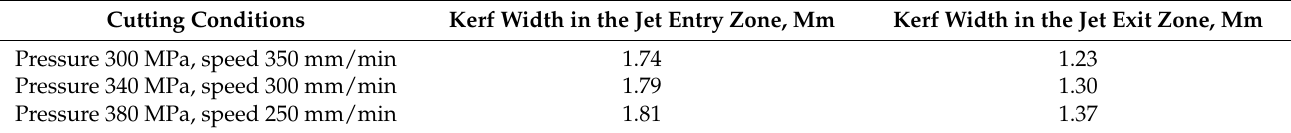
Table 4. Kerf width after cutting at an abrasive flow rate of 250